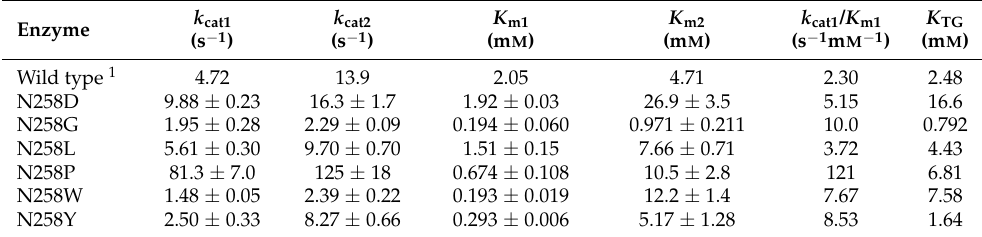
Table 1. Kinetic parameters of BspAG13_31A Asn258 variants to pNPG. Enzyme